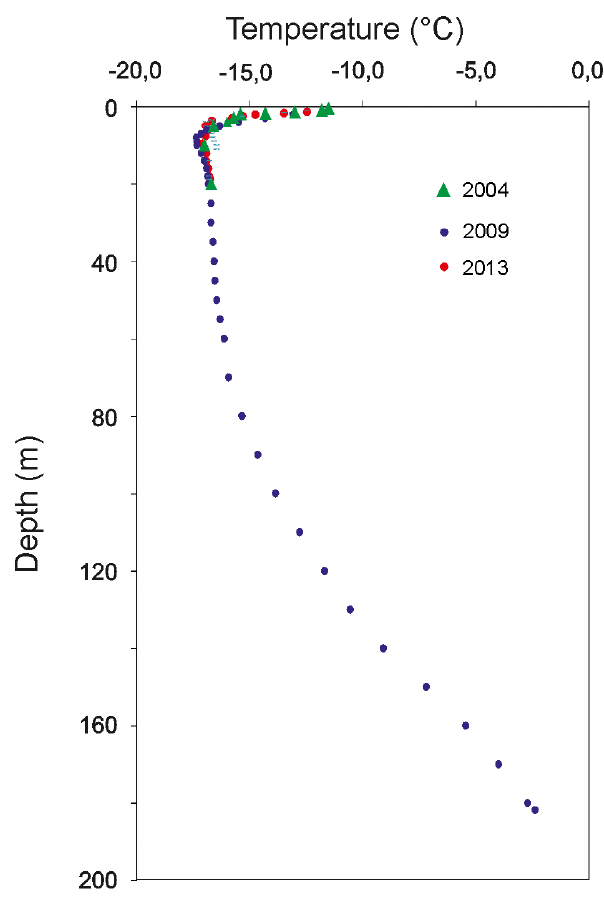
Figure 6. Measured temperature profiles at the western Elbrus plateau drill site for different dates: green triangles show the 22m depth borehole drilled in 2004, blue dots show the main 2009 bore- hole, and red dots show the 20m depth borehole drilled in